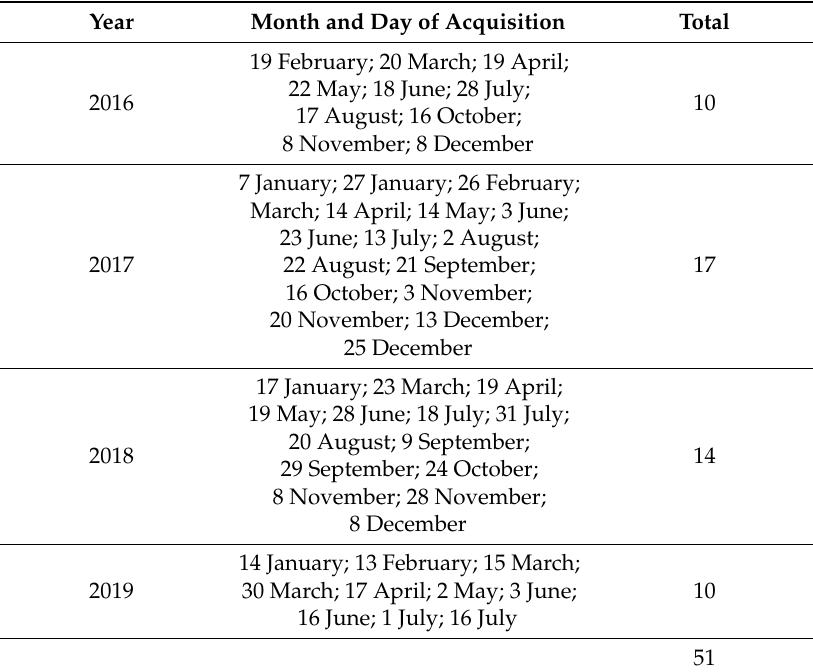
Table 1. List of Sentinel-2